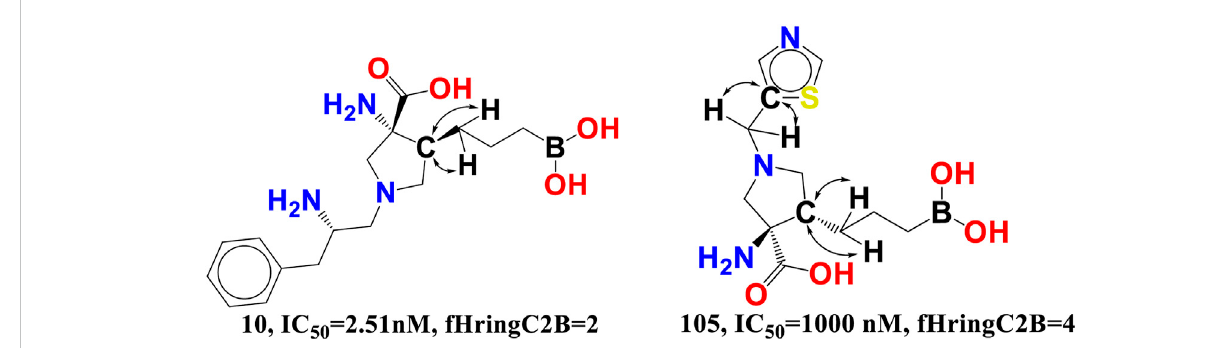
FIGURE 8 Presentation of the molecular descriptor fHringC2B for the molecules 10 and 105 only.